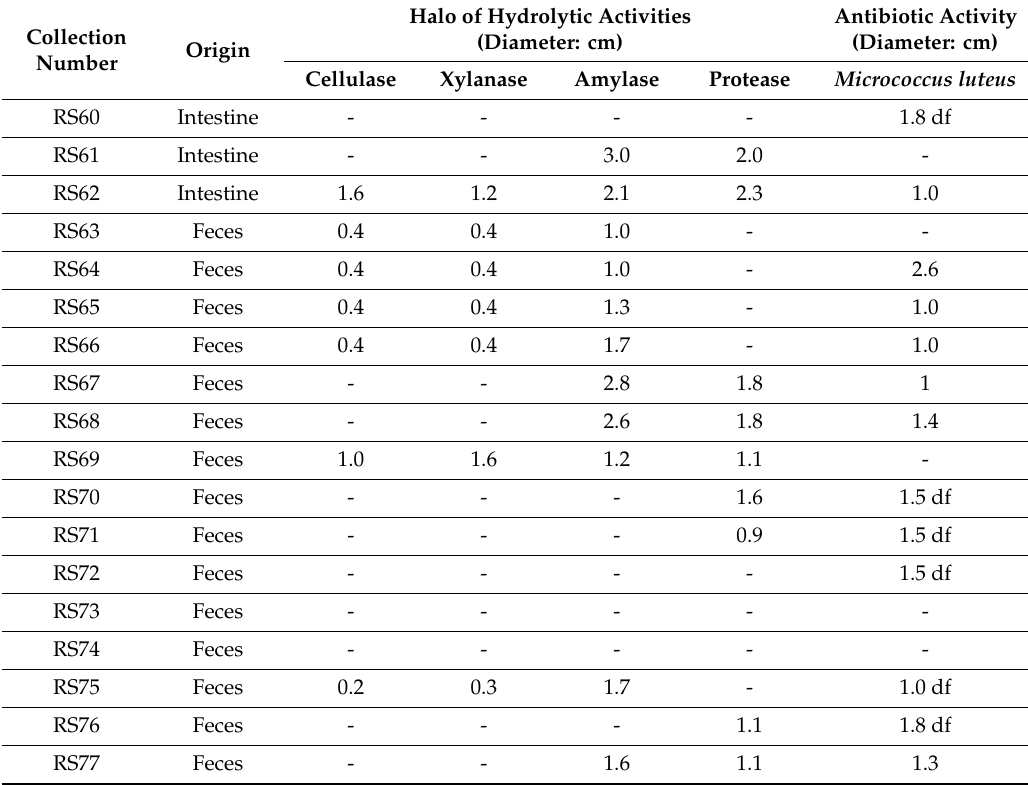
Figure 1. Morphology of the actinomycetes selected for molecular identification. The selected strains for molecular identification were isolated from intestine (RS60 and RS62) and from feces (RS64, RS65, RS68, RS70, RS71, RS72, RS77 and RS78). A portion of 3 cm of a normal petri dish is shown in each panel. The cultures were carried out on R2YE and incubated at 28 ◦ C for 8 days. Table 1. Hydrolytic and antibiotic activities of the actinomycetes isolated from Cerambyx welensii larvae. (-): No activity; df: di ff use halo with non-sharp